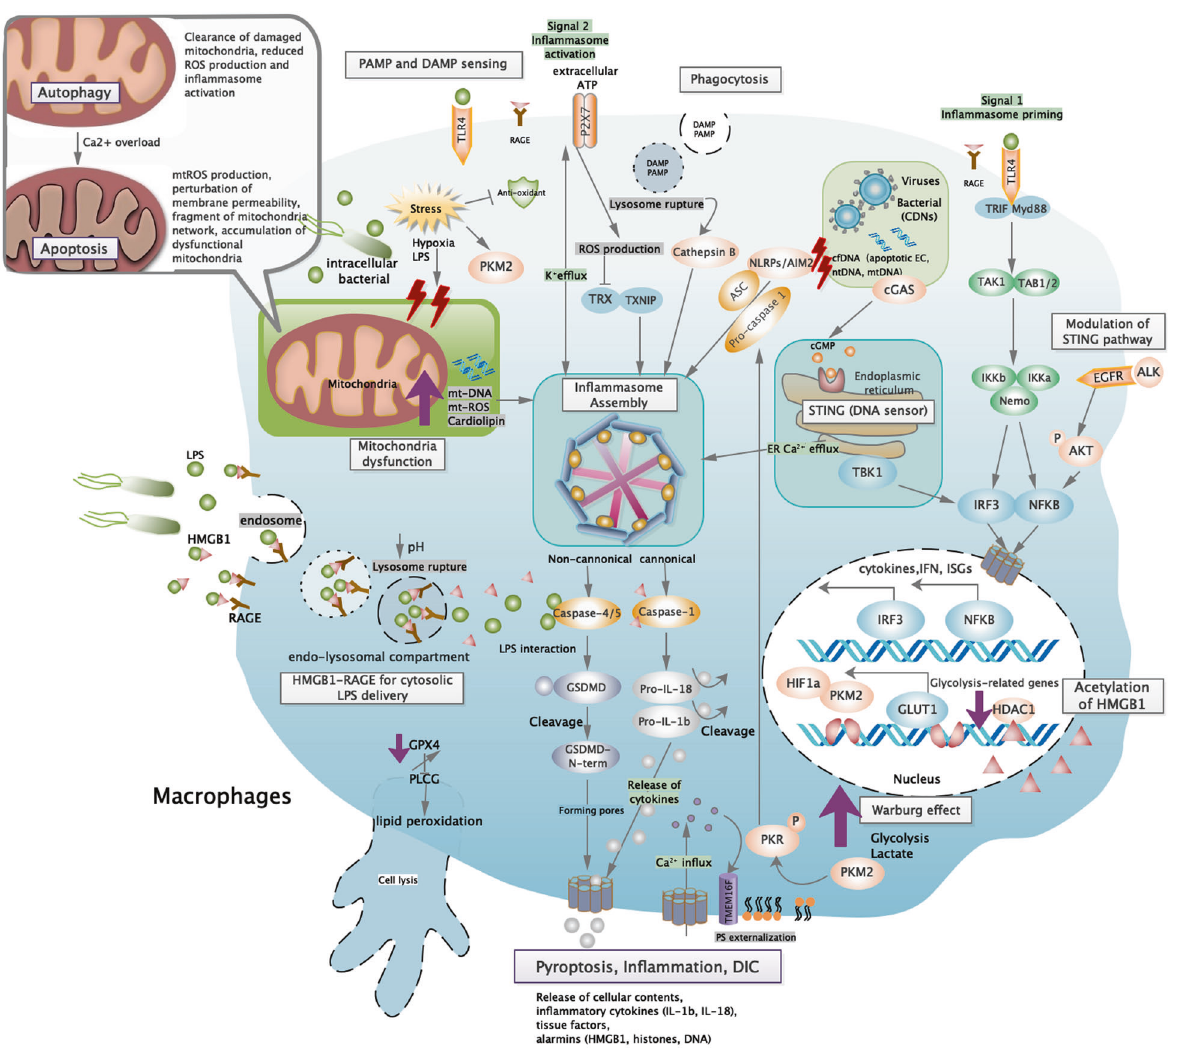
Fig. 1 Cross-talks of signaling pathway in innate immune cells. At initiation of sepsis, innate immune cells are generally activated at recognition of DAMPs and PAMPs. Membrane-bound and intracellular receptors sense danger signals, which converge with multiple pathways related to activation and regulation of innate immune responses. In general, these converge toward IRF3 and NF- κ B signaling pathway that are required to initiate early phase in fl ammatory responses. Besides, TLR4 agonist (i.e., LPS or HMGB1) provide essential priming signal for the fi rst step of in fl ammasome activation — upregulation of pro-in fl ammatory genes. Another substantial group of pathogenic products and endogenous alarmins were required to provide signal 2 for AIM2/NLRP3 in fl ammasome assembly, which subsequently cleave caspase, GSDMD, and pro-IL-1 β /18 to drive canonical in fl ammasome activation and pyroptosis. Acting as late-phase alarmin, HMGB1 interact with RAGE for delivery of cytosolic LPS, which further trigger pyroptosis via caspase-11-dependent pathway (equivalent to caspase-4 and caspase-5 in human, non-canonical pathway). Intracellularly, cytosolic DNA derived from apoptotic cells or intracellular pathogen could be sensed by AIM2 and cGAS-STING to induce in fl ammasome assembly and IRF3 phosphorylation, leading to type I interferon responses and in fl ammasome activation. During sepsis, persisted stress stimuli result in mitochondria dysfunction, ROS production, and metabolism reprogramming that further enhance redox state modi fi cation and alarmin production (HMGB1). These cellular changes activate multiple signaling pathways that converge with NLRP3 in fl ammasome activation. In fl ammasome plays a pivotal role in sepsis pathogenesis due to its cross-talk with stress signaling, immune cell activation, and cell homeostasis. Interaction between in fl ammatory and coagulation cascades serve as underlined mechanism for DIC pathogenesis. As a cytosolic LPS receptor, caspase-11 participated in initiation of coagulation by enhancing tissue factor (TF) activity, performed by GSDMD pore-mediated Ca 2 + ef fl ux that trigger PS externalization, while macrophage pyroptosis facilitate release of cellular contents including procoagulant products (TF) and alarmins to sustain systemic coagulation. ROS reactive oxygen species, DAMP damage-associated molecular pattern, PAMP pathogen-associated molecular pattern, cfDNA cell-free DNA, EC endothelial cells, ER endoplasmic reticulum, ASC apoptosis-associated speck-like protein, TRX thioredoxin, TXNIP thioredoxin-interacting protein, HMGB1 high mobility group box protein 1, RAGE receptor for advanced glycation end products, GPX4 glutathione peroxidase 4, PLCG phospholipase C gamma 1, PKM2 pyruvate kinase M2, PKR RNA-activated protein kinase, HDAC1 histone deacetylase 1, GLUT1 glucose transporter 1, HIF1a hypoxia-inducible factor-1, PS phosphatidylserine, GSDMD gasdermin bacterial cell lysis. These distinct properties of complements regulate early innate immune responses and are essential for protecting host from uncontrolled dissemination of invasive pathogens. The complement cascade was known to be activated